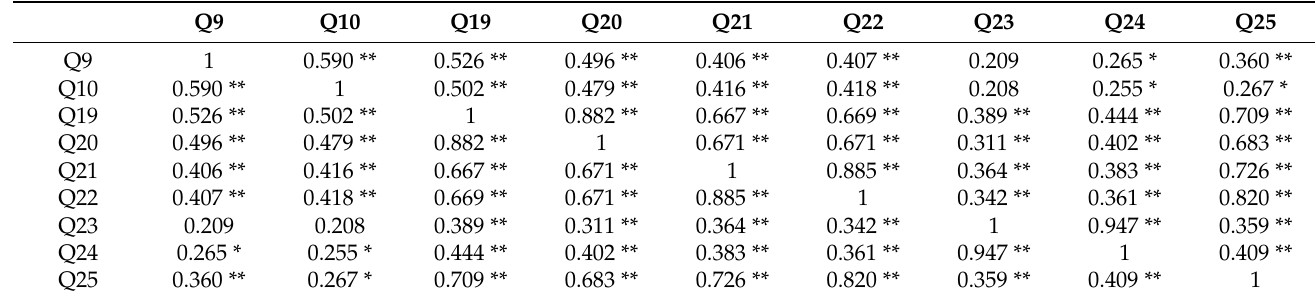
Table 5. Pearson’s correlation coefficients of the nine questions ( N =